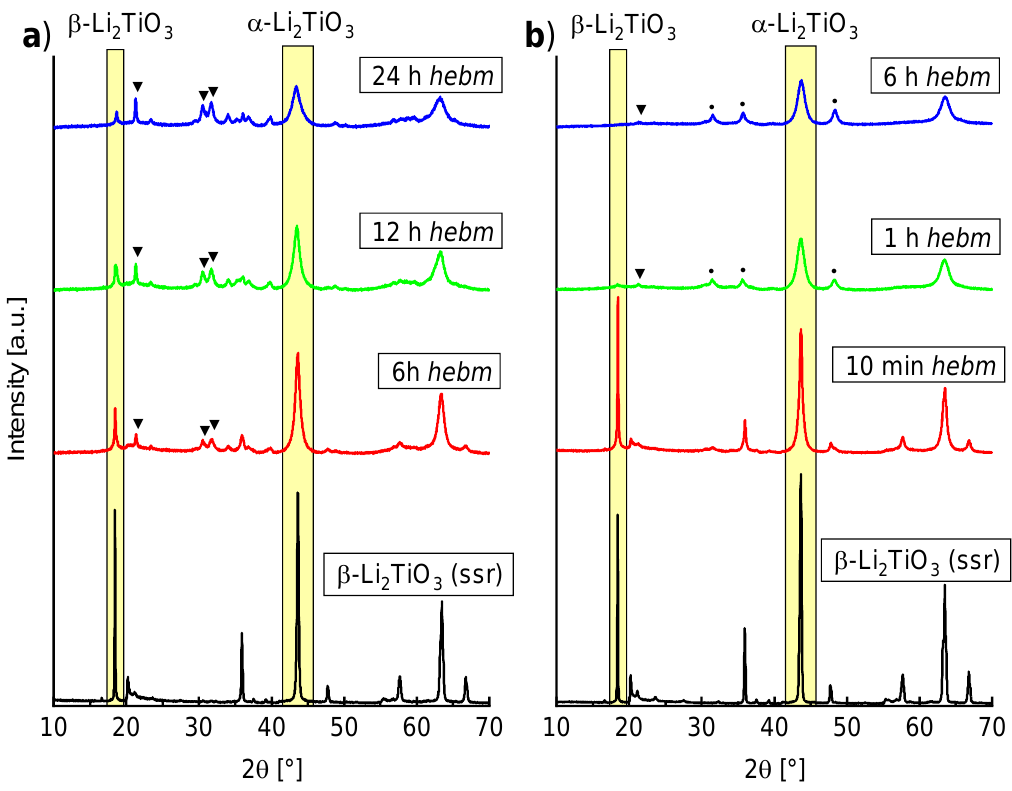
Figure 7. PXRD measurements of β -Li 2 TiO 3 after milling in ( a ) ZrO 2 and ( b ) WC tools at 600 rpm after different grinding times. Triangles indicate Li 2 CO 3 , circles indicate WC.